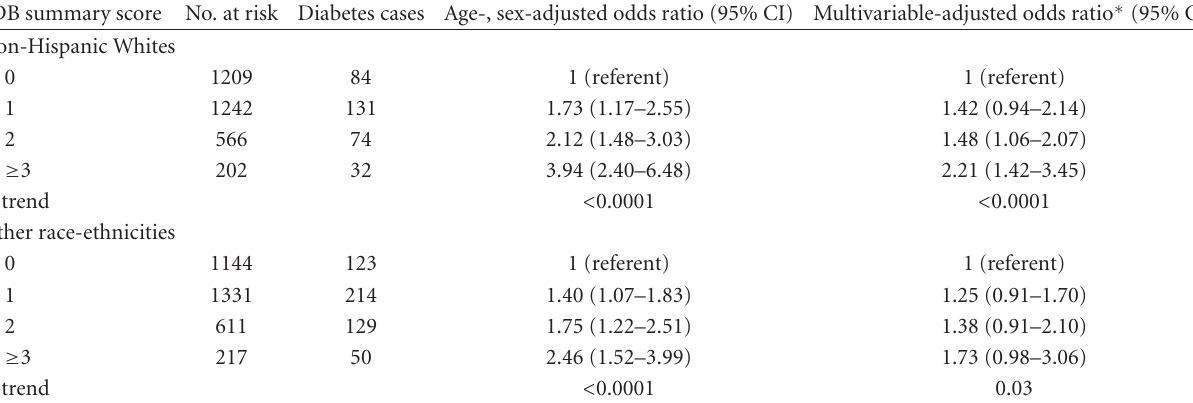
Table 3: Association between SDB and diabetes mellitus, by race/ethnicity.